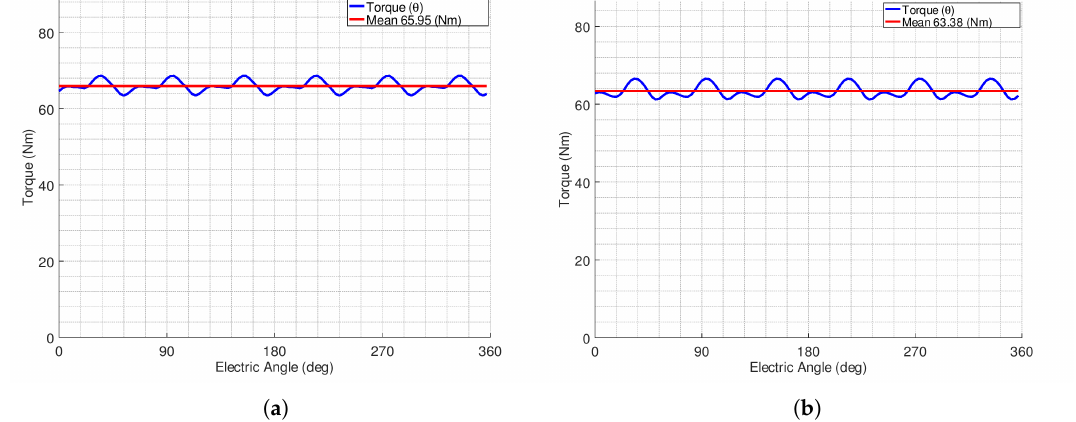
Figure 8. Torque profiles with sinusoidal currents: ( a ) reference SPM; ( b ) proposed IPM.